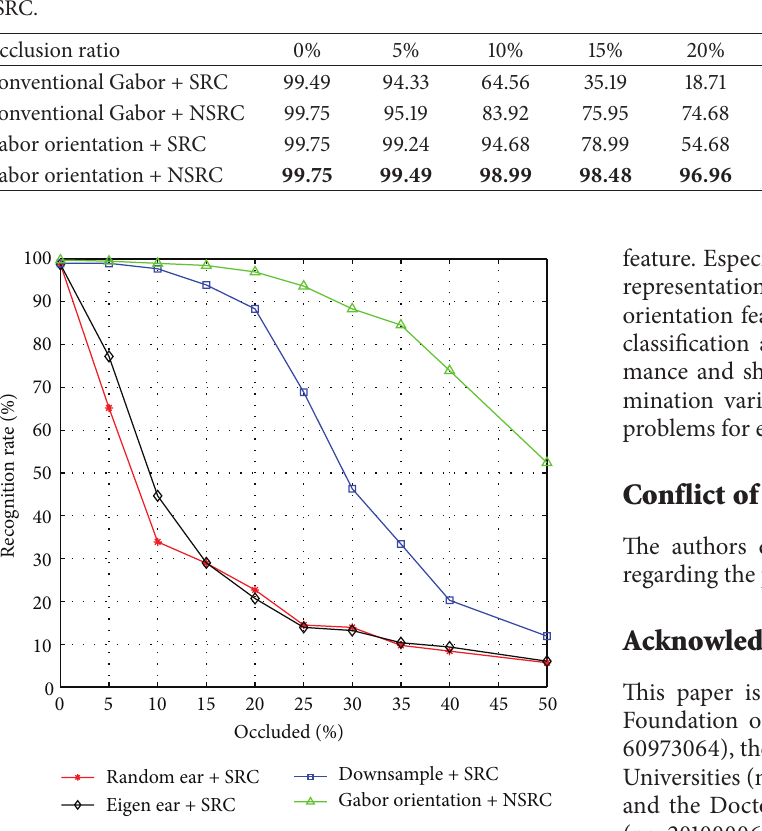
Table 2: Recognition performance comparisons between conventional Gabor feature and the proposed Gabor orientation using SRC AND NSRC.